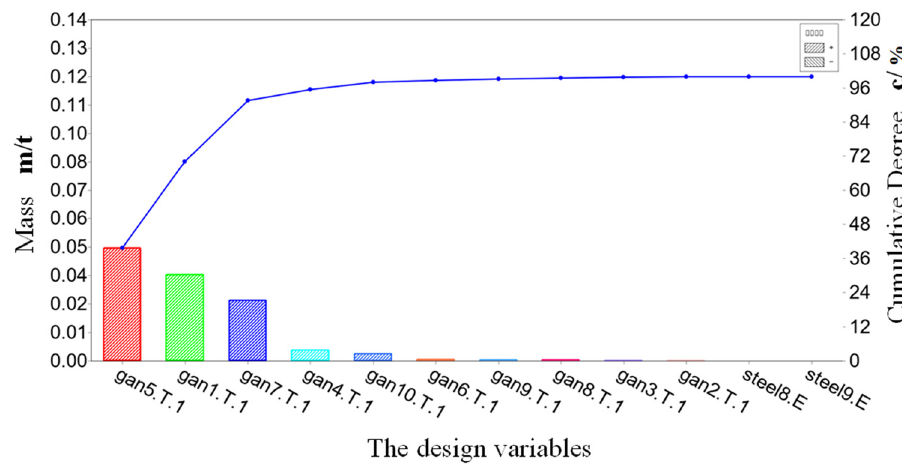
Figure 13: The result of the sensitivity analysis for mass